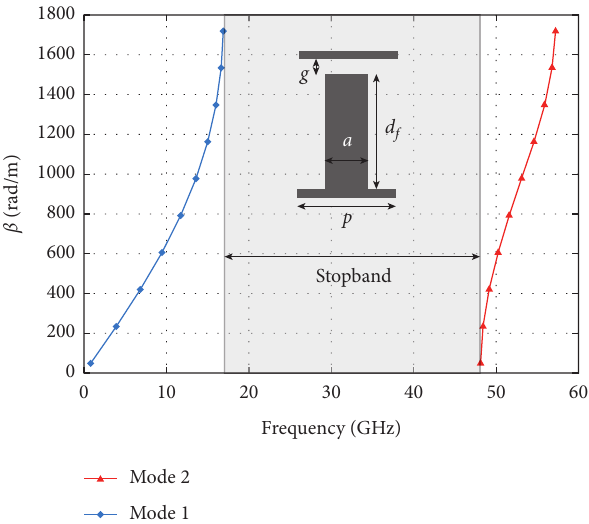
Figure 2: Dispersion diagram for the pin unit cell ( p � 1.77mm,